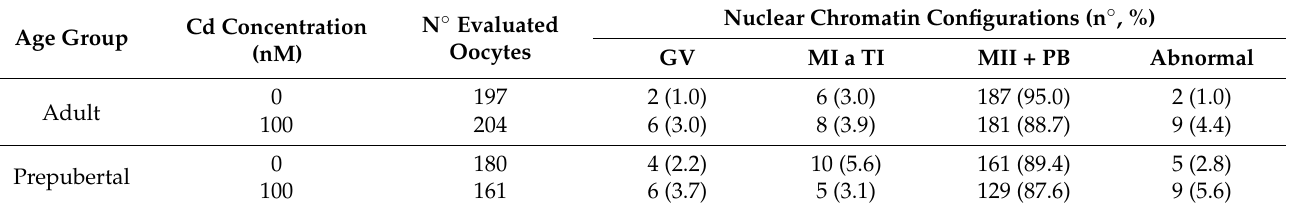
Table legend: GV = Germinal Vesicle; MI = Metaphase I; TI = Telophase I; MII = Metaphase II; PB = Polar Body. Chi-square test: Not significant. Seven and eight replicates were performed for adult and prepubertal groups, respectively. A replicate included CCs from 20–30 COCs, each of them individually cultured in 10 µ L/microdrop placed in a 60 mm petri dish and selected after IVM for belonging to a MII oocyte.